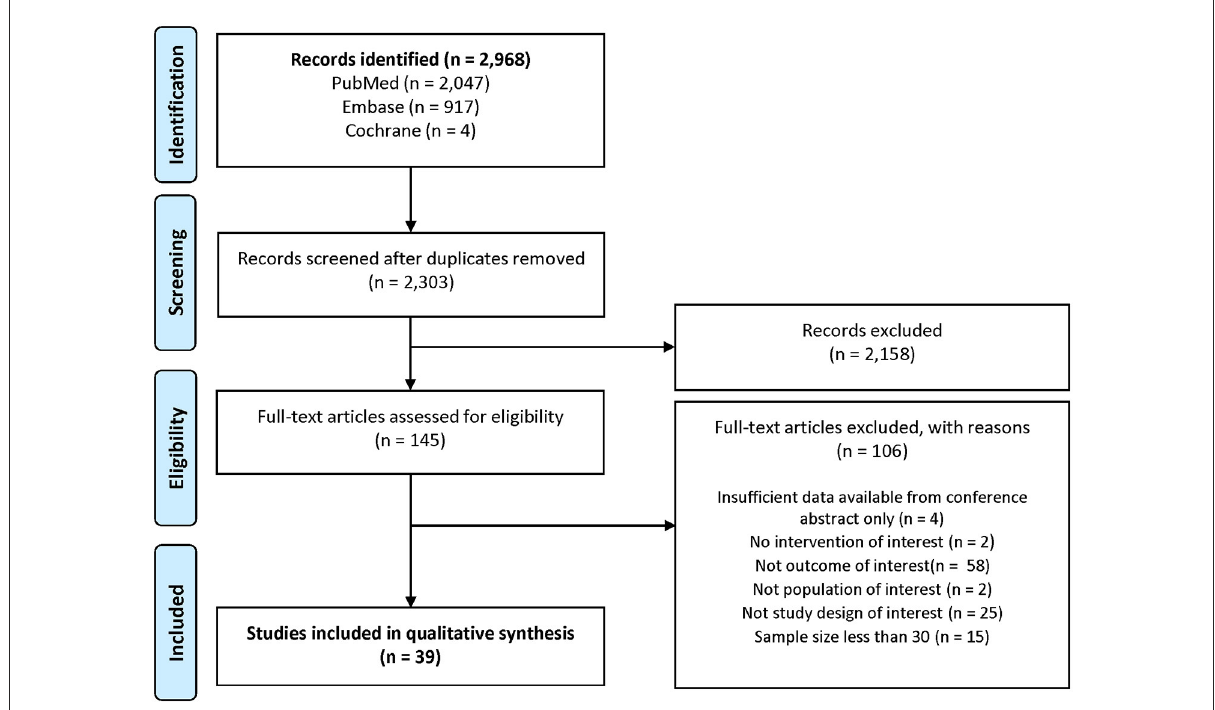
FIGURE1 PRISMA study attrition